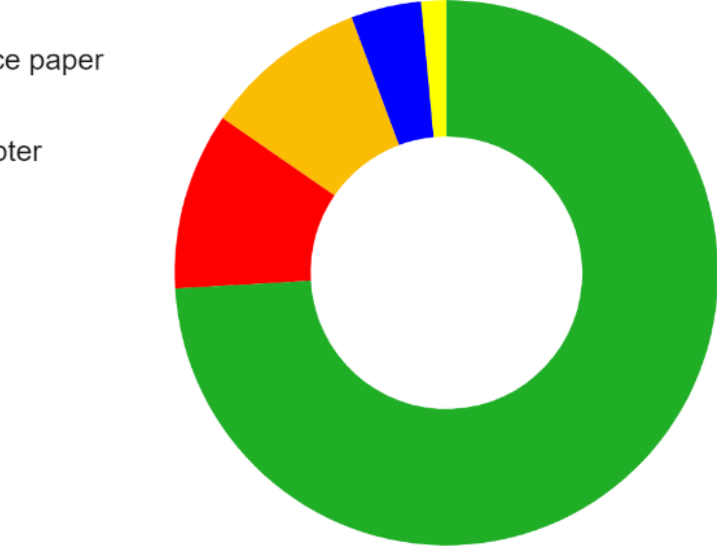
Figure 5. Distribution of search results from Scopus by document type.